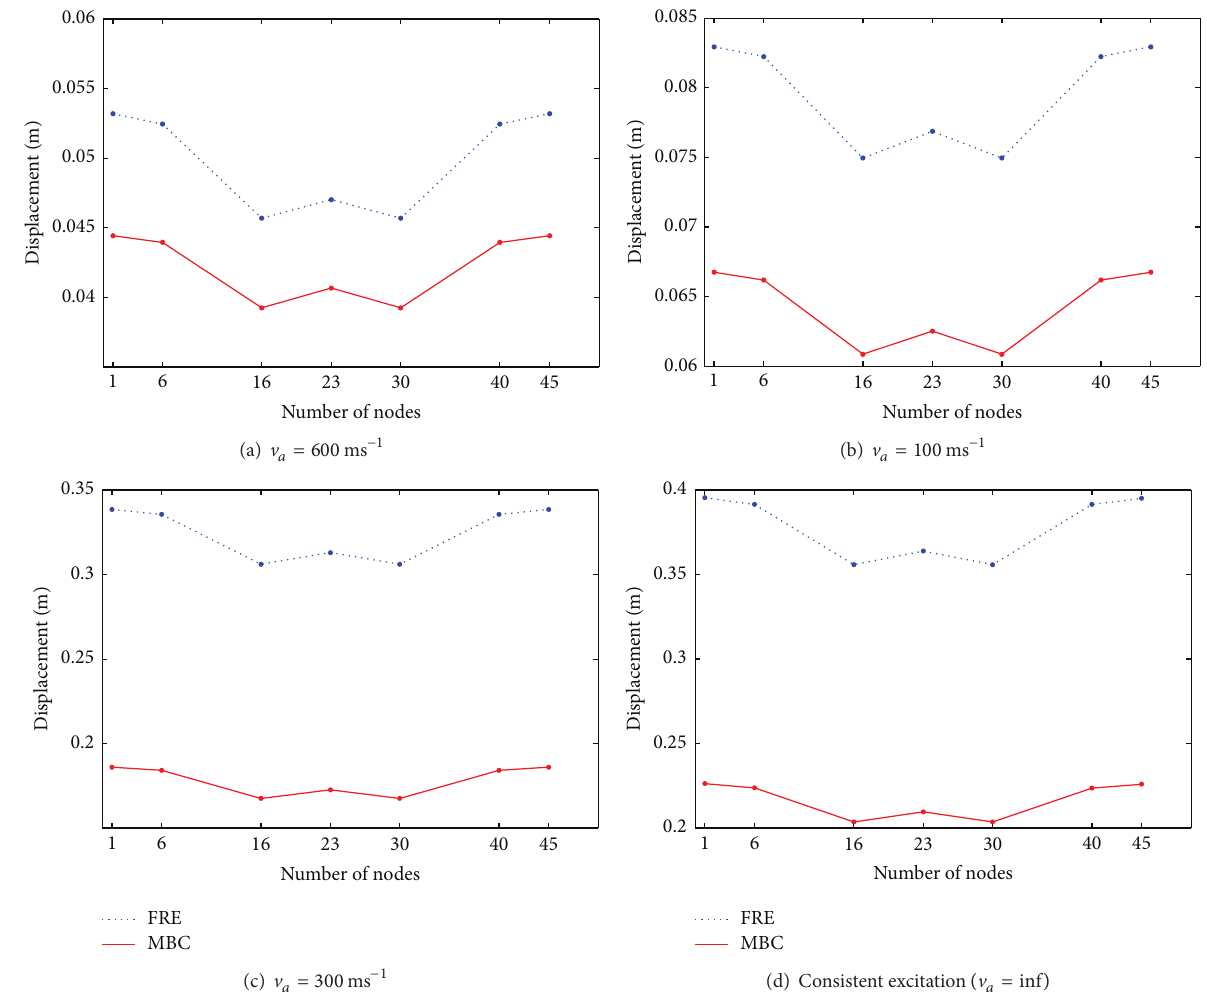
Figure 15: Displacement response with and without control at various velocities of travelling